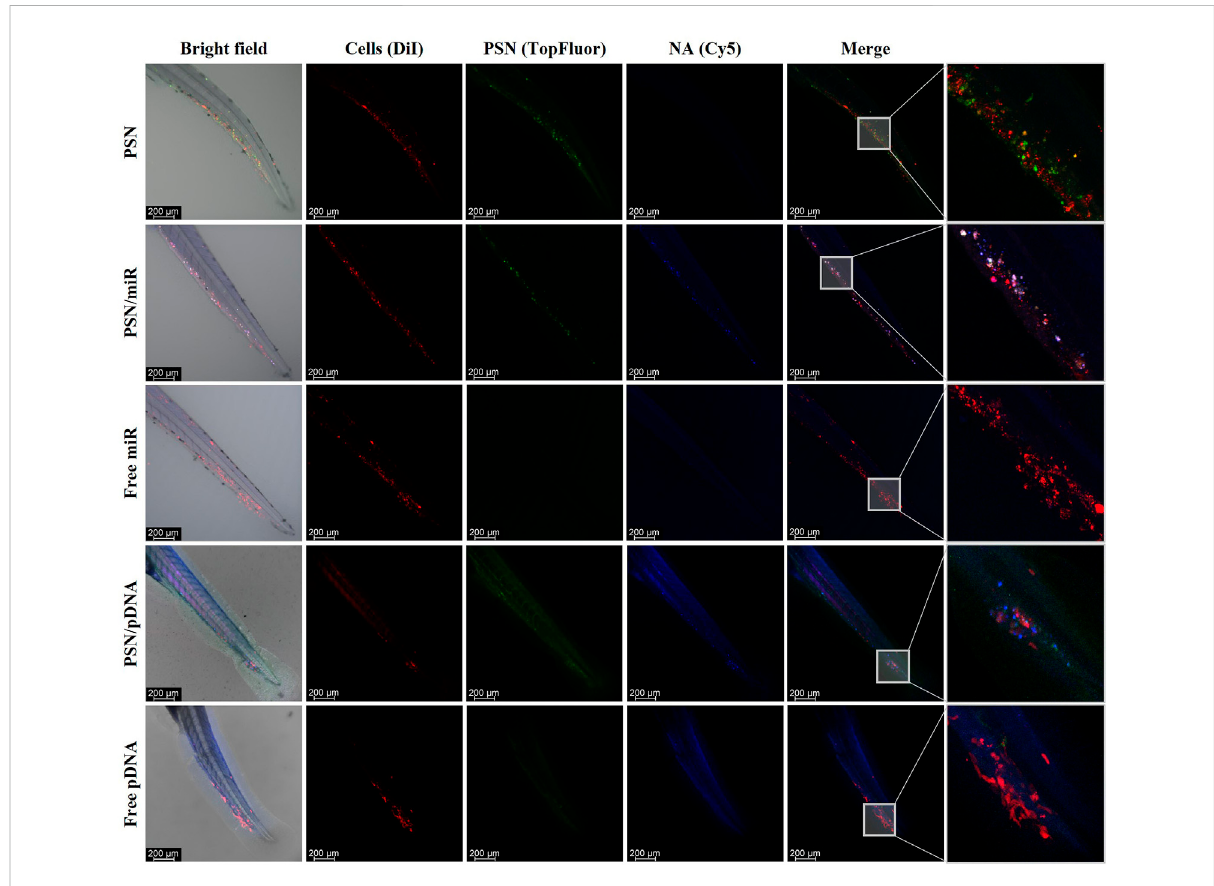
FIGURE 5 Images of the in vivo interaction between nanoemulsions, labelled with TopFluor (green), and associated and non-associated miR and pDNA Cy5-labelled (blue) with DiI-MDA-MB-231 cancer cells (red), by confocal